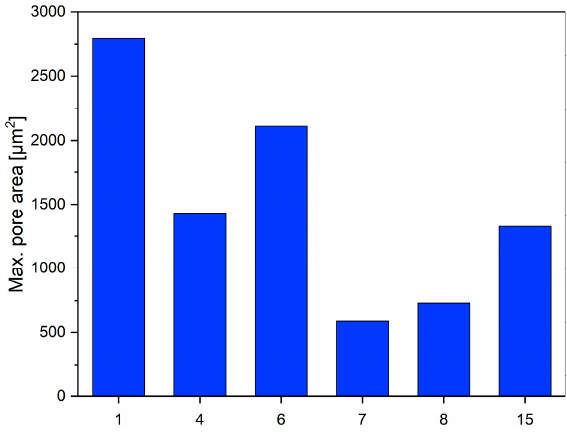
Figure 8. Maximum pore area for the six most promising sets. Table 6. Parameter sets and relative VED values.